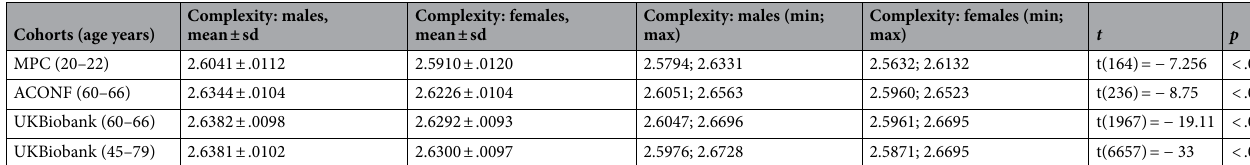
Table 1. Differences in whole brain complexity (FD) between sexes for all data sets: the Indian sample (Mysore Parthenon Cohort, MPC), Scottish (Aberdeen Children of the 1950s, ACONF) and UK Biobank.